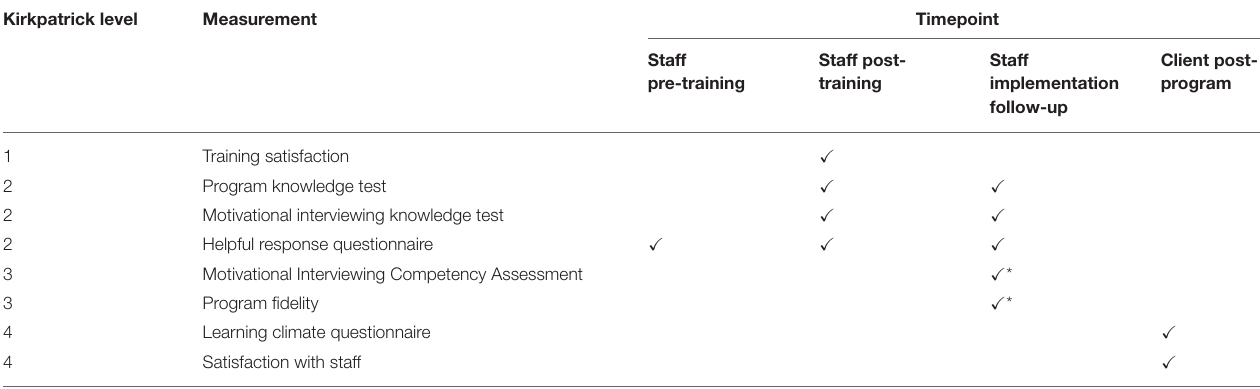
TABLE 1 | Overview of measurement